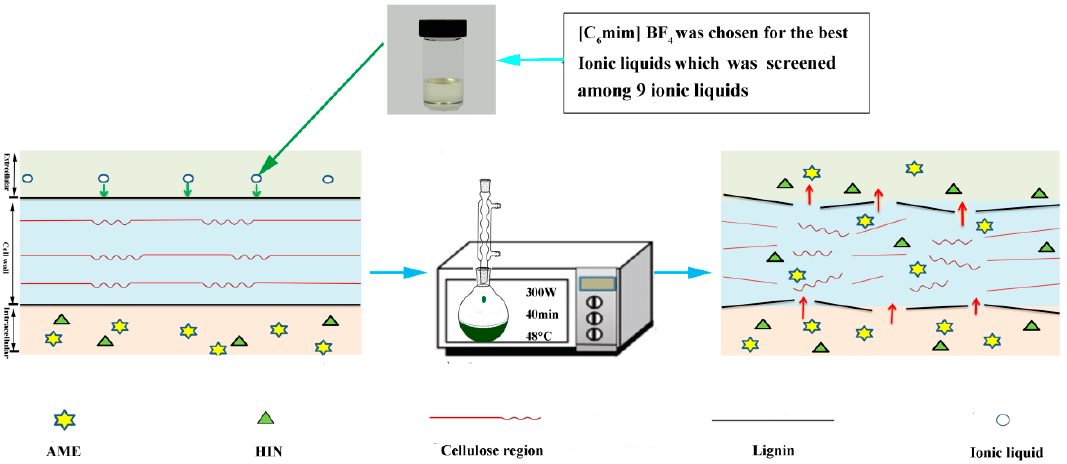
Figure 11. Contribution of IL and MAE to improve the extraction efficiency of AME and HIN.